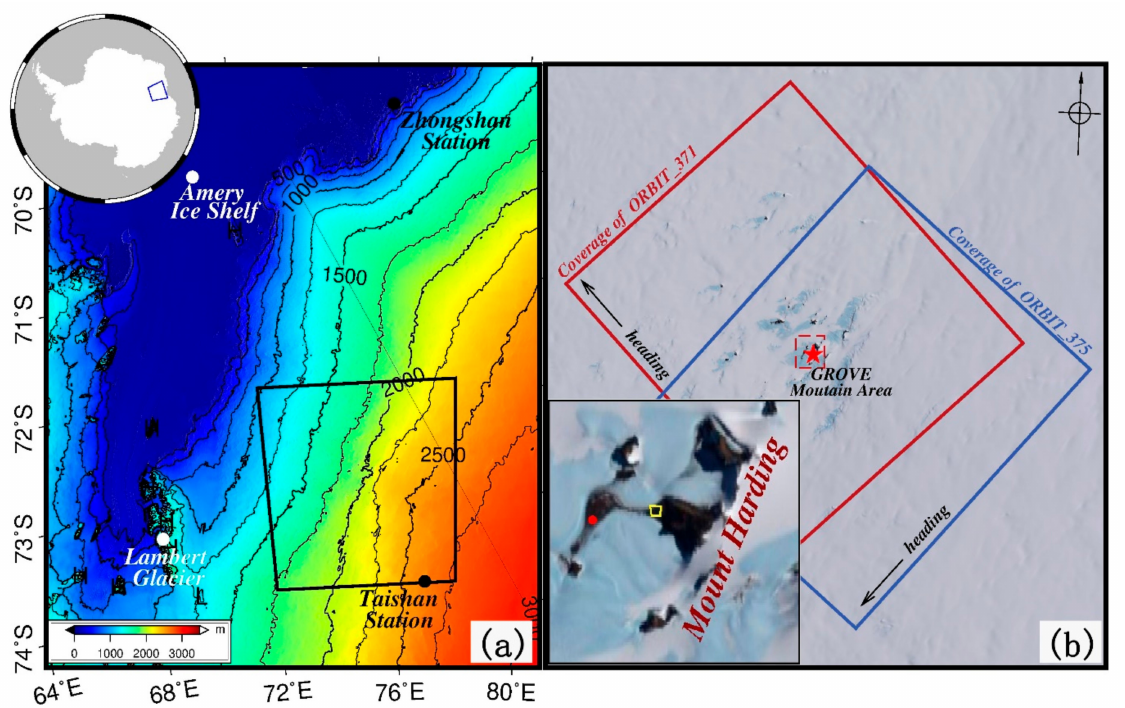
Figure 1. Location of the Grove Mountains area ( a ) and the coverage of SAR datasets ( b ). Black box in ( a ) shows the coverage of ( b ). Red and blue boxes indicate the coverage of ascending and descending datasets,